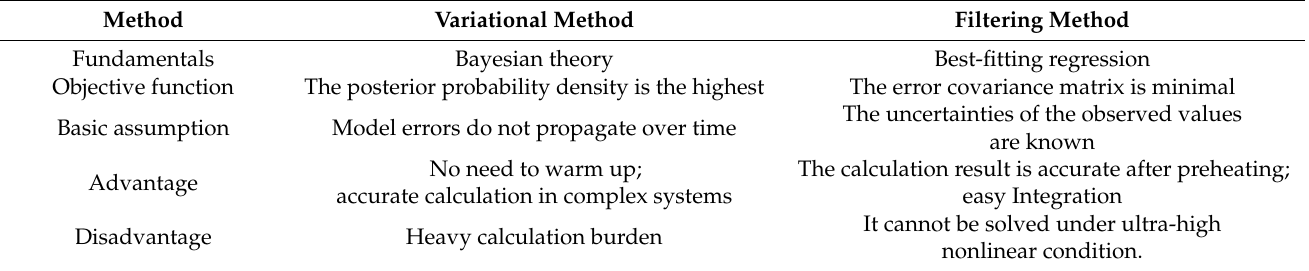
Table 1. Comparison of commonly used data assimilation